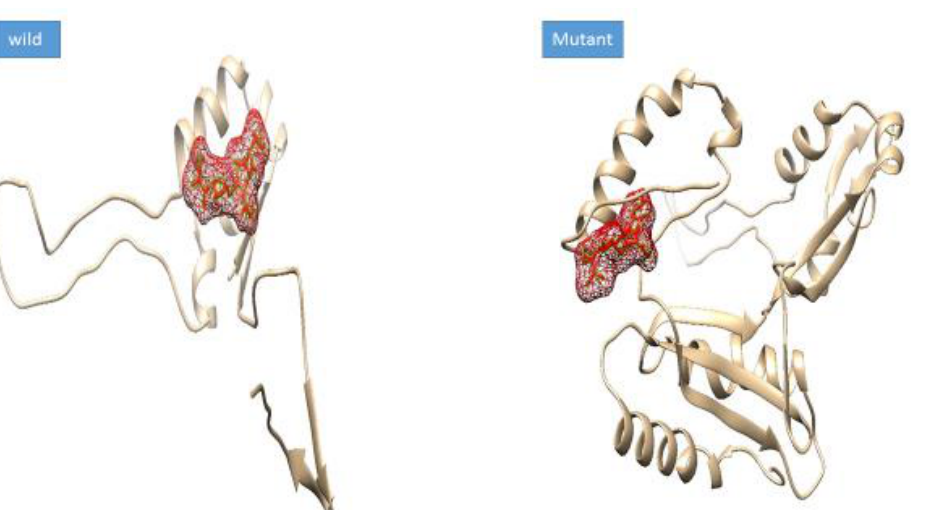
Figure 9. MexA wild and mutant intermolecular-docked complex with meropenem. The proteins are shown in tan cartoon style while the ligands are given in mesh.